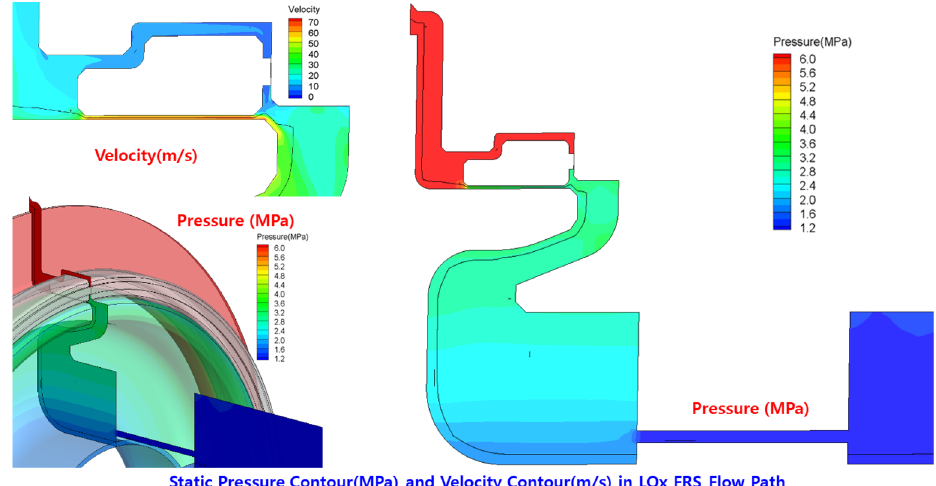
Figure 7. Static pressure (MPa) and velocity (m/s) distributions around floating ring seal at 0 rpm.